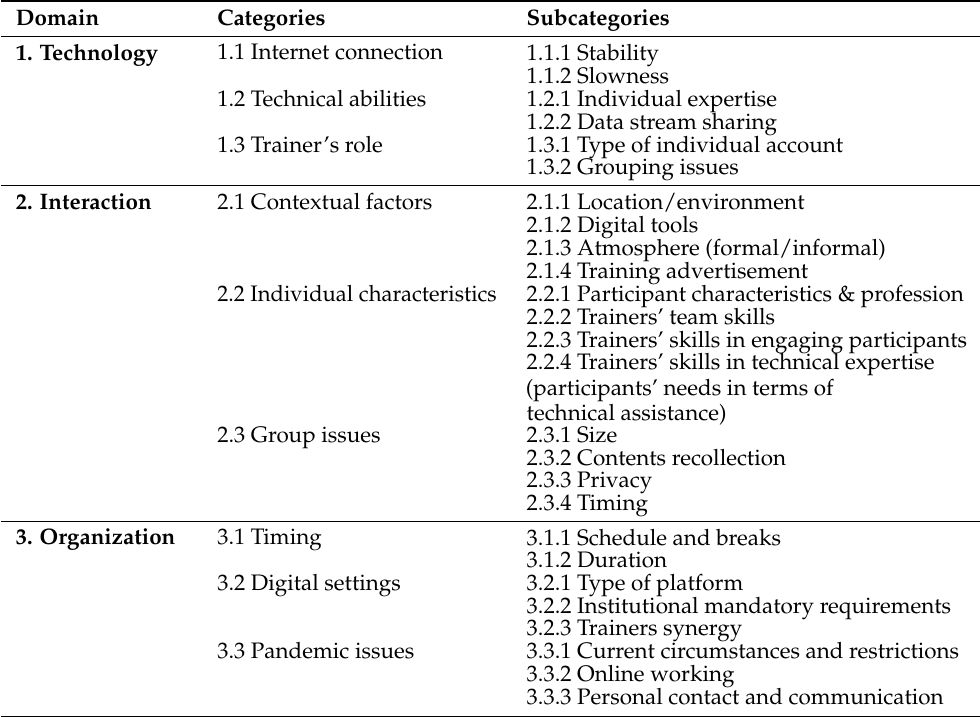
Table 2. Main categories from content analysis of ERICA digital trainers’